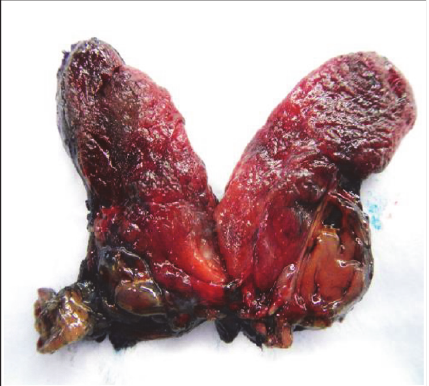
Figure 2: Circumscribed tan intrathyroidal 2.5 × 1.7 × 1.5 cm mass abutting the margin